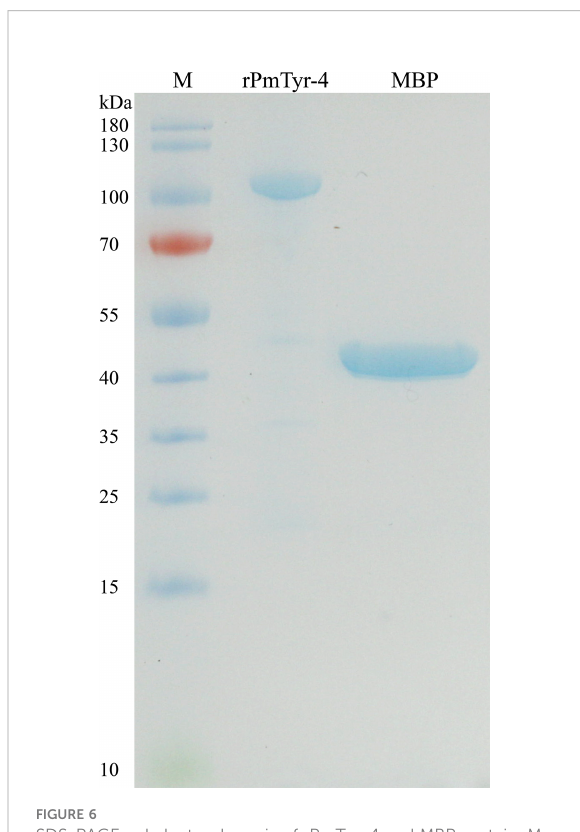
FIGURE 6 SDS-PAGE gel electrophoresis of rPmTyr-4 and MBP protein. M: